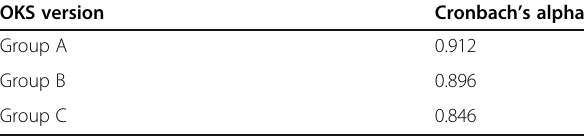
Table 3 Internal consistency for 3 different OKS versions